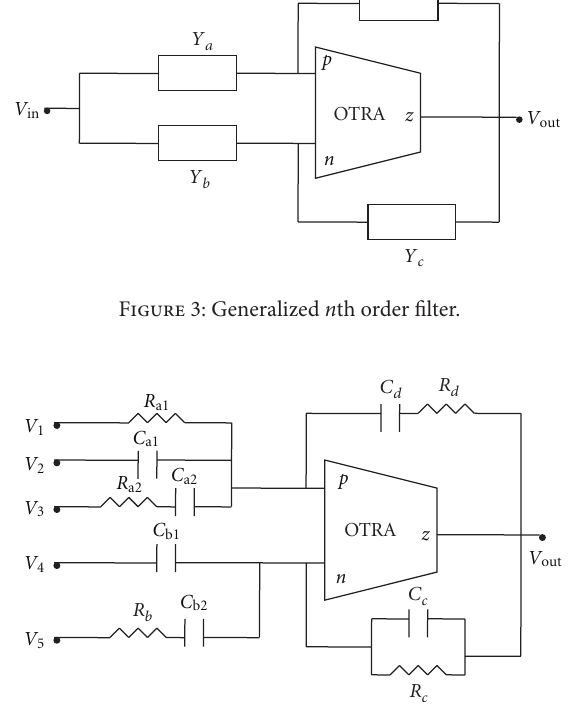
F 4: Proposed third order uni�ersal